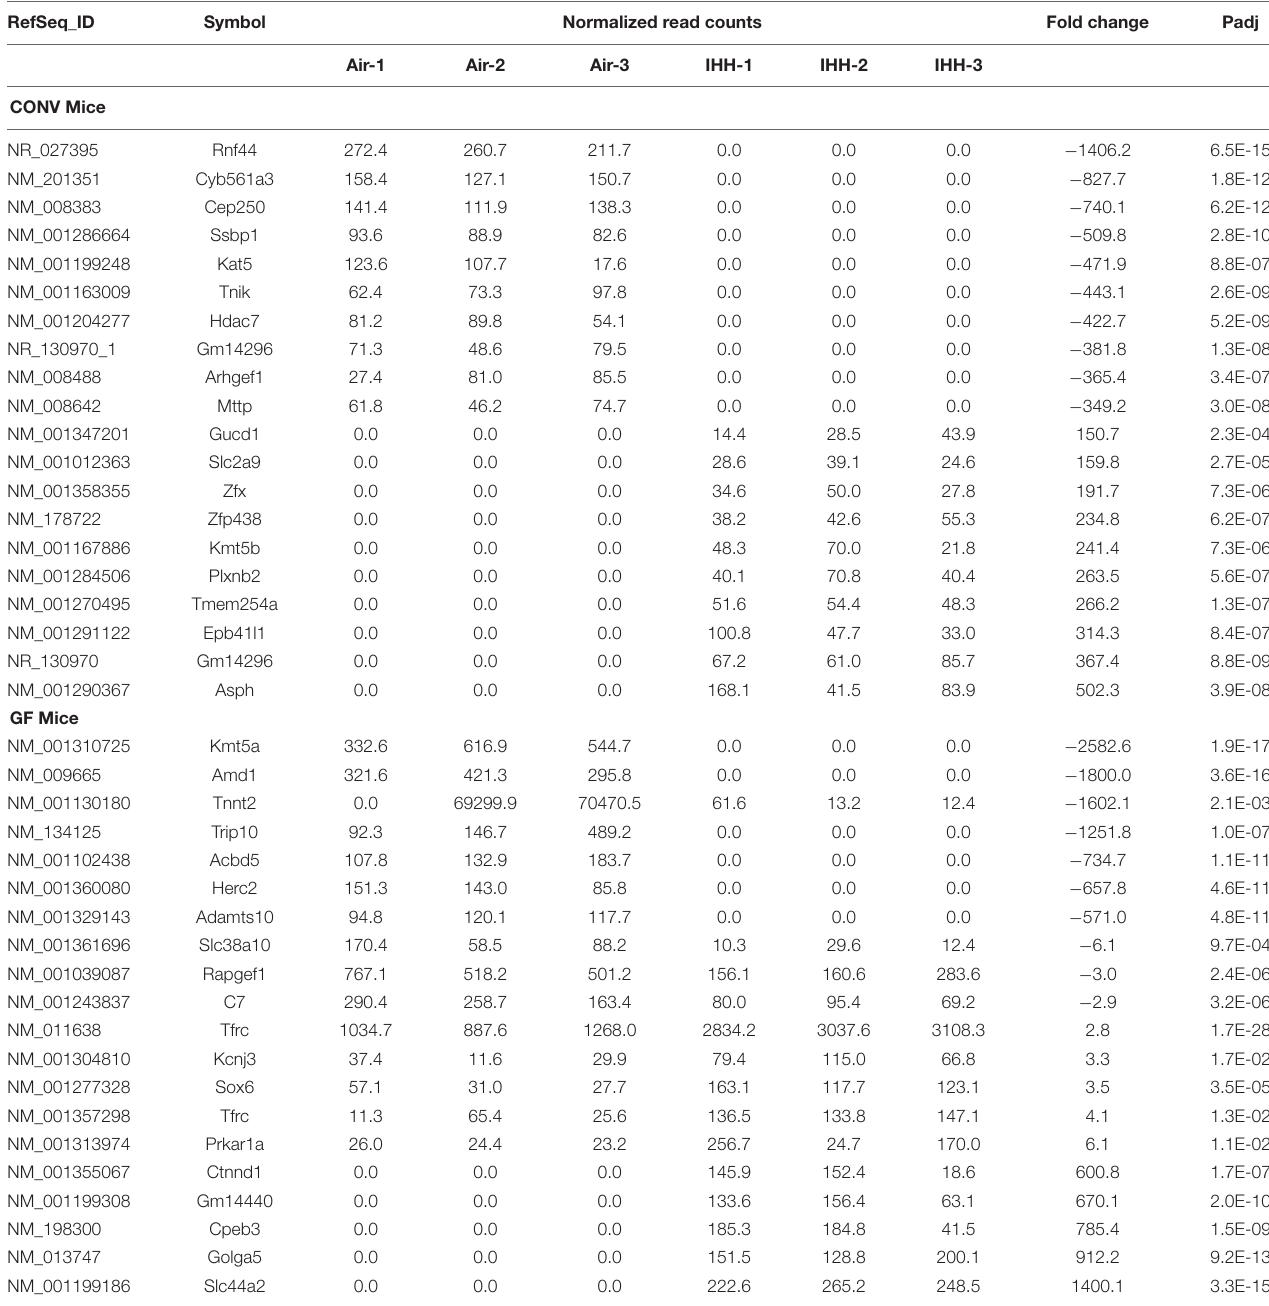
TABLE 1 | Top transcriptional alterations in CONV and GF mice following IHH